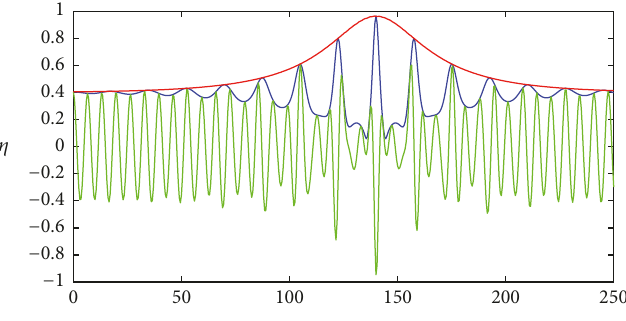
;̃𝑘;̂ ] ) = (0.2; 0.9186; 1) 0